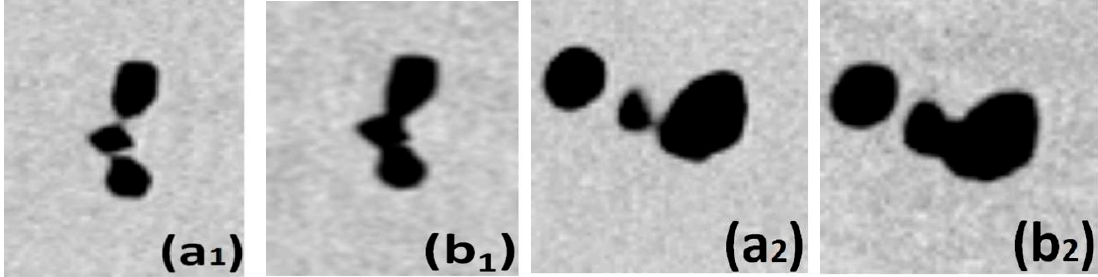
Figure 4. Graphs are local enlarged diagrams ( a 1 ) 0 s; ( b 1 ) 15 s; ( a 2 ) 0 s; ( b 2 ) 15 s.